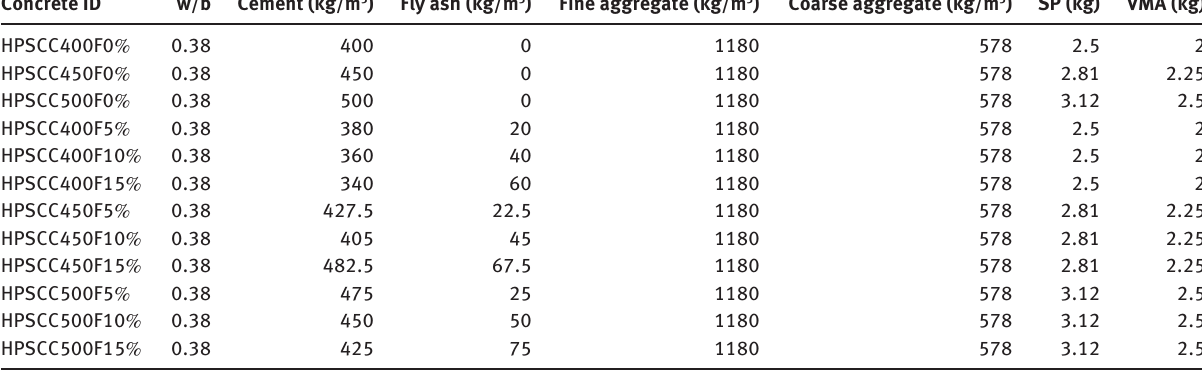
Table 5 Mixed proportion of the concretes.